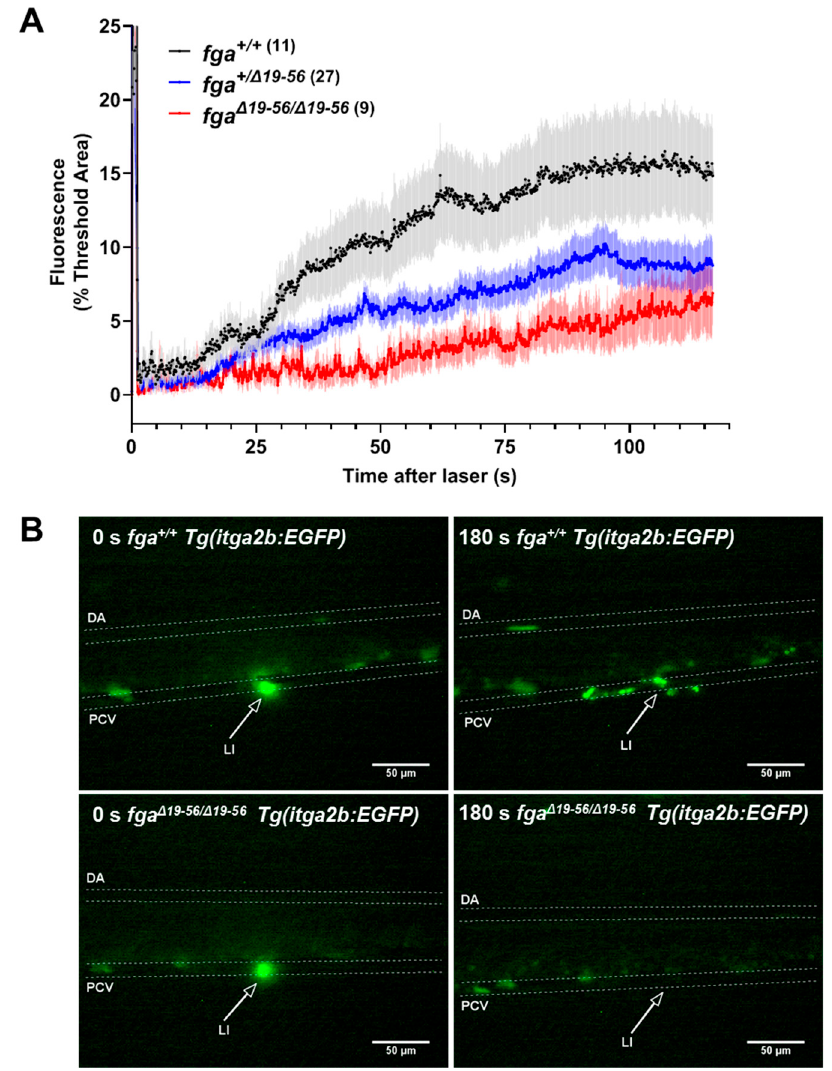
Figure 6. Thrombocyte adhesion and aggregation in a hypodysfibrinogenemia model. ( A ) Fluorescent thrombocyte bind- ing and adhesion in 5 dpf Tg(itga2b:EGFP) embryos after laser injury of the PCV over time in fga +/+ , fga +/ Δ 19 − 56 and fga Δ 19 − 56/ Δ 19 − 56 genotypes. Each line represents the mean (+/-SEM) of thrombocyte fluorescence reaching a threshold fluores- cence within a defined area. ( B ) Time lapse images of fga +/+ and fga Δ 19 − 56/ Δ 19 − 56 larvae upon (0 s) and 180 s after laser injury. Fluorescence from the laser is seen at 0 s and where green fluorescent thrombocytes accumulate at 180 s. The dorsal aorta (DA), posterior cardinal vein (PCV) and site of laser injury (LI, arrows) are